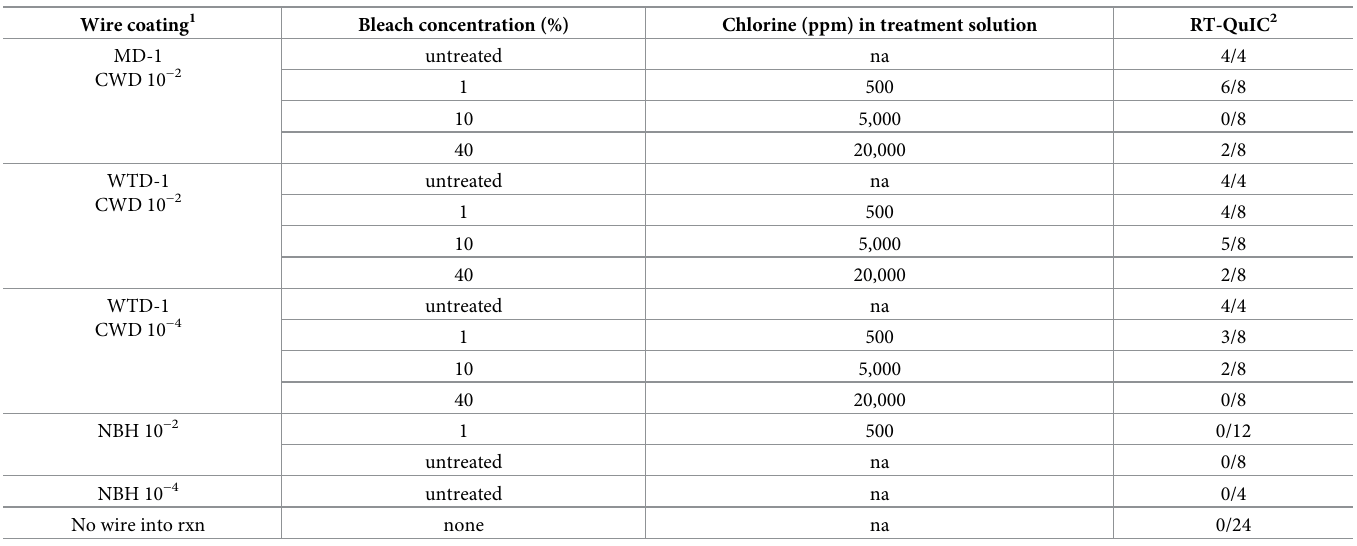
Table 2. One-minute bleach treatments of CWD-coated wires.